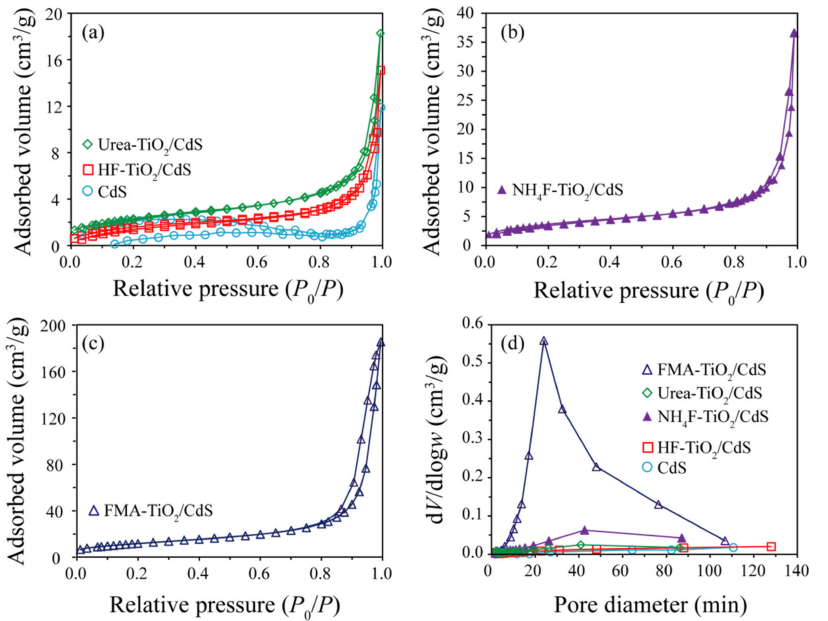
Figure 6. Nitrogen adsorption–desorption isotherms of the as-prepared ( a ) CdS, HF-TiO 2 /CdS, Urea-TiO 2 /CdS, ( b ) NH 4 F-TiO 2 /CdS, and ( c ) FMA-TiO 2 /CdS samples, and ( d ) the corresponding of pore size distribution curves.